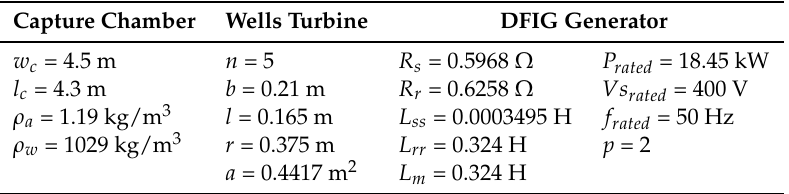
Table 1. Plant parameters from the NEREIDA wave power plant at Mutriku. Capture